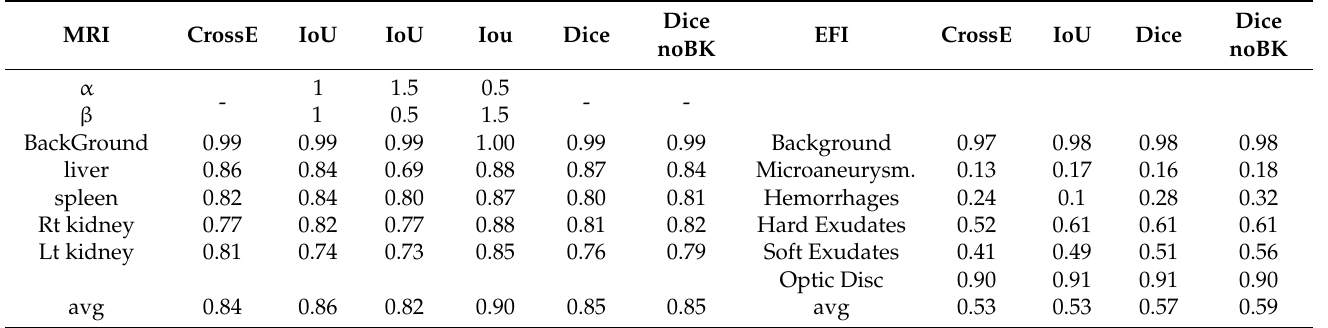
Table 2. IoU of segmentation network DeepLabV3 with diff. loss functions, two datasets (MRI, EFI).